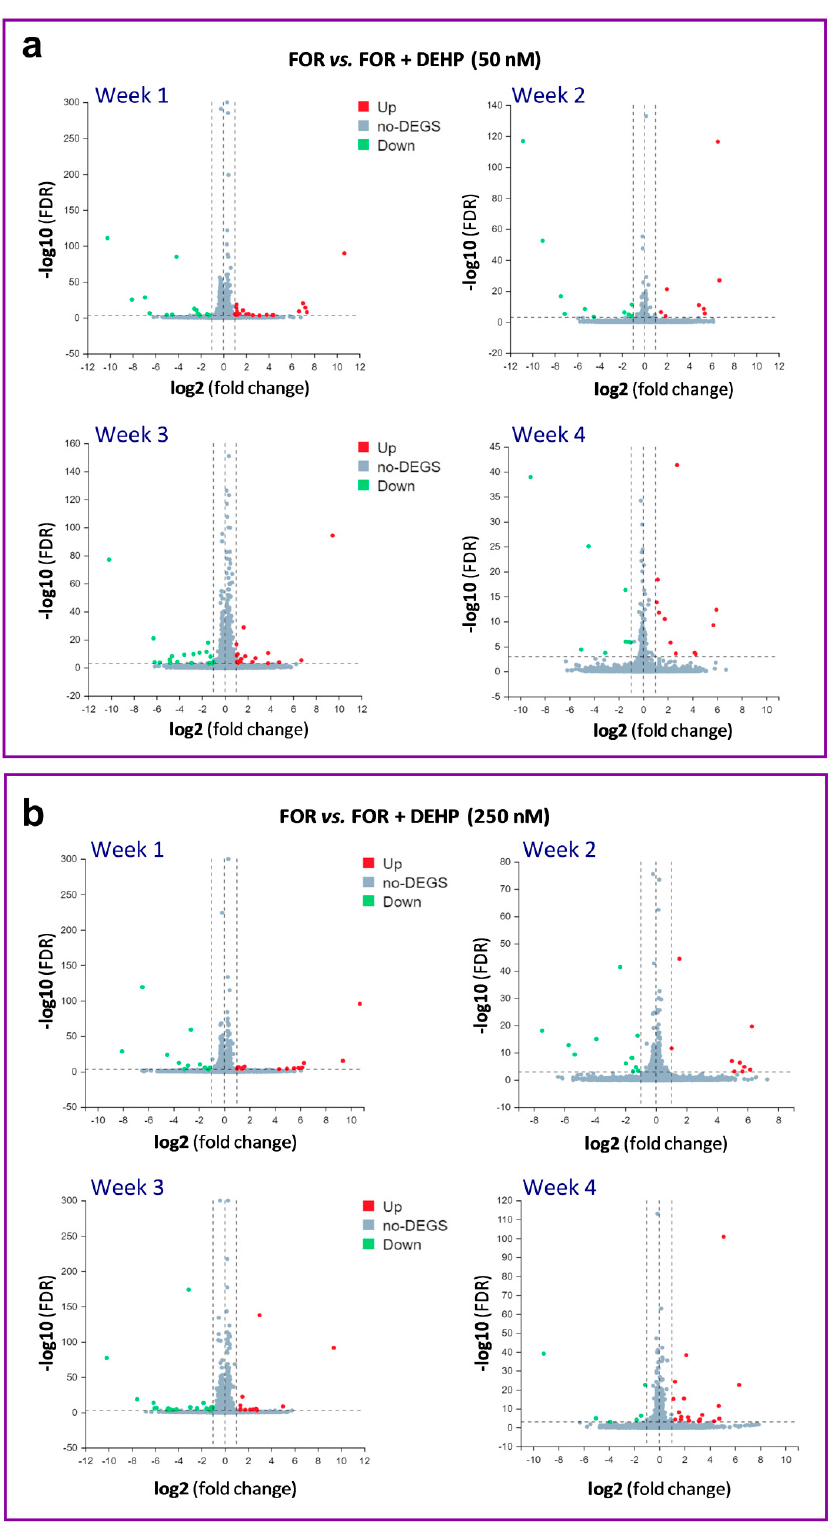
Figure 4. Volcano scatter plots of mRNA expression in DEHP-exposed HGrC1 cells stimulated with FOR. ( a ) DEHP50 and ( b ) DEHP250 compared to the FOR-stimulated group. The X-axis represents the fold change of the difference after conversion to log2, and the Y-axis represents the significance value (false discovery rate, FDR) after conversion to − log10. In each plot, significantly upregulated genes are highlighted in red, and downregulated genes are highlighted in green. Non-significant findings are represented as grey dots.